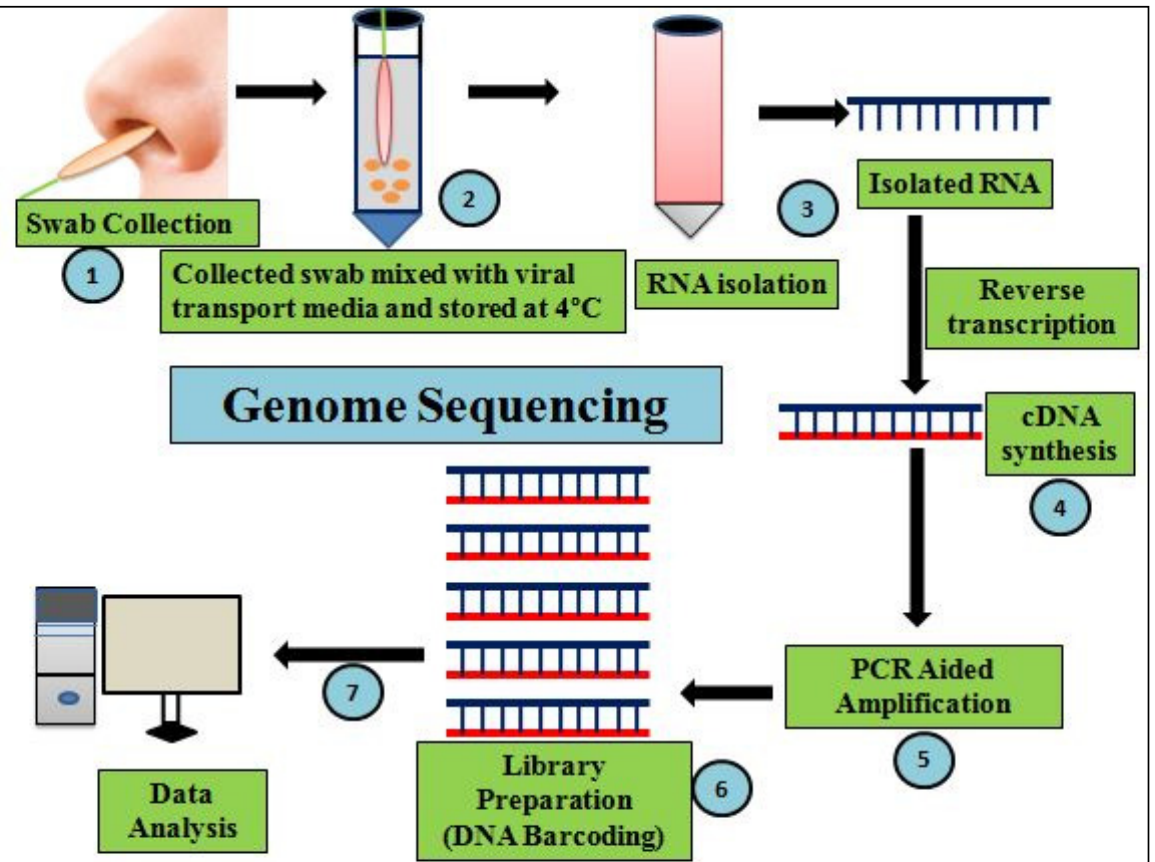
Figure 5. Genome sequencing for detection of SARS-CoV-2 variants: ( 1 ) swab/test sample collection from an individual; ( 2 ) mixingthe collected sample with viral transport media and storage at 4 °C;